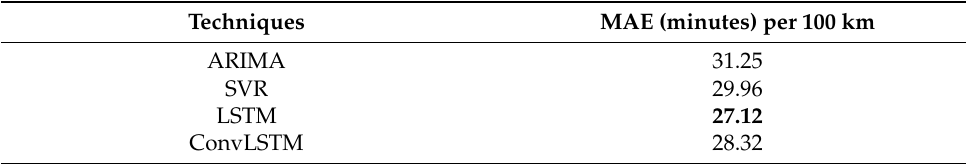
Table 3. Performance report of the time-series prediction techniques: Autoregressive Integrated Moving Average (ARIMA), Support Vector Regression (SVR), Long Short-Term Memory (LSTM), and Convolutional LSTM (ConvLSTM), evaluated by Mean Absolute Error (MAE).